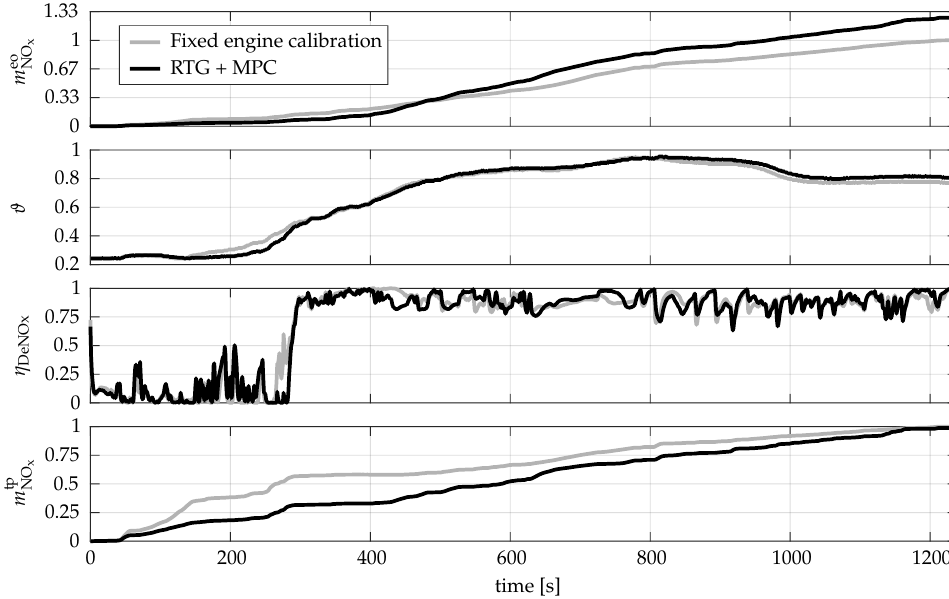
Figure 7. Comparison of the measurement obtained with the fixed engine calibration (gray) to that obtained with the predictive supervisory controller (black) for the NRTC. Using the predictive supervisory controller reduced the fuel consumption by 1.1%. All values were